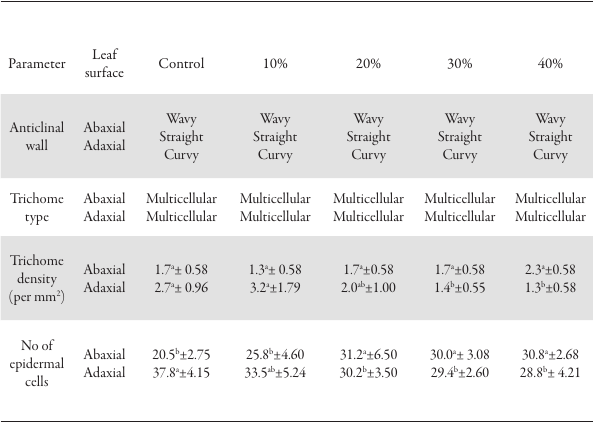
Tab. 1. Epidermal features of leaves of A. hybridus irrigated with various concentrations of pharmaceutical effluents